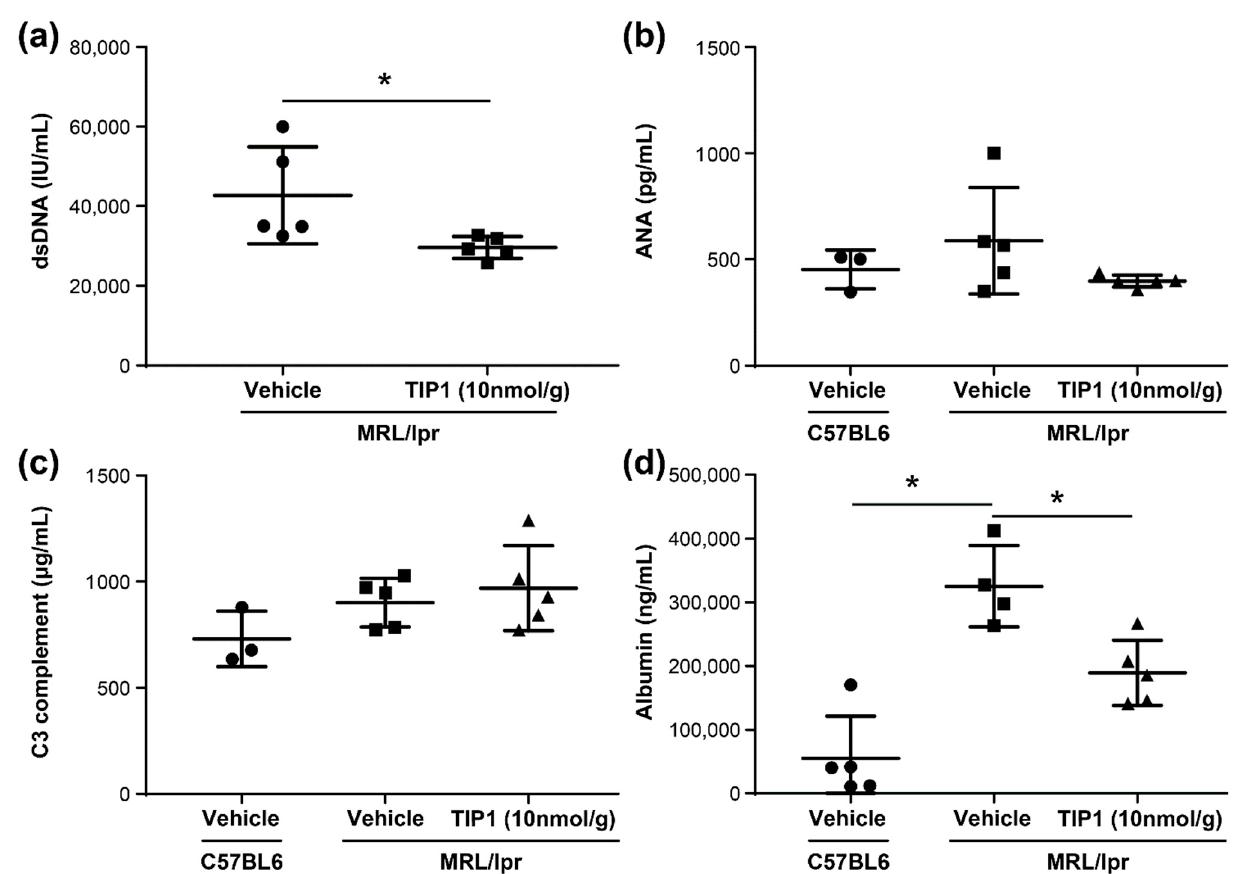
Figure 2. ( a ) Anti-dsDNA antibodies, ( b ) anti-nuclear antibodies (ANA), ( c ) C3 complement levels in the serum, and ( d ) albumin content in the urine as determined by enzyme-linked immunosorbent assays (ELISAs). All experiments were performed in duplicate wells (n = 4–5 mice/group). The exact Mann–Whitney U test was performed to compare the mean values between groups. * p < 0.05. TIP1, Toll-like receptor inhibitor peptide 1.